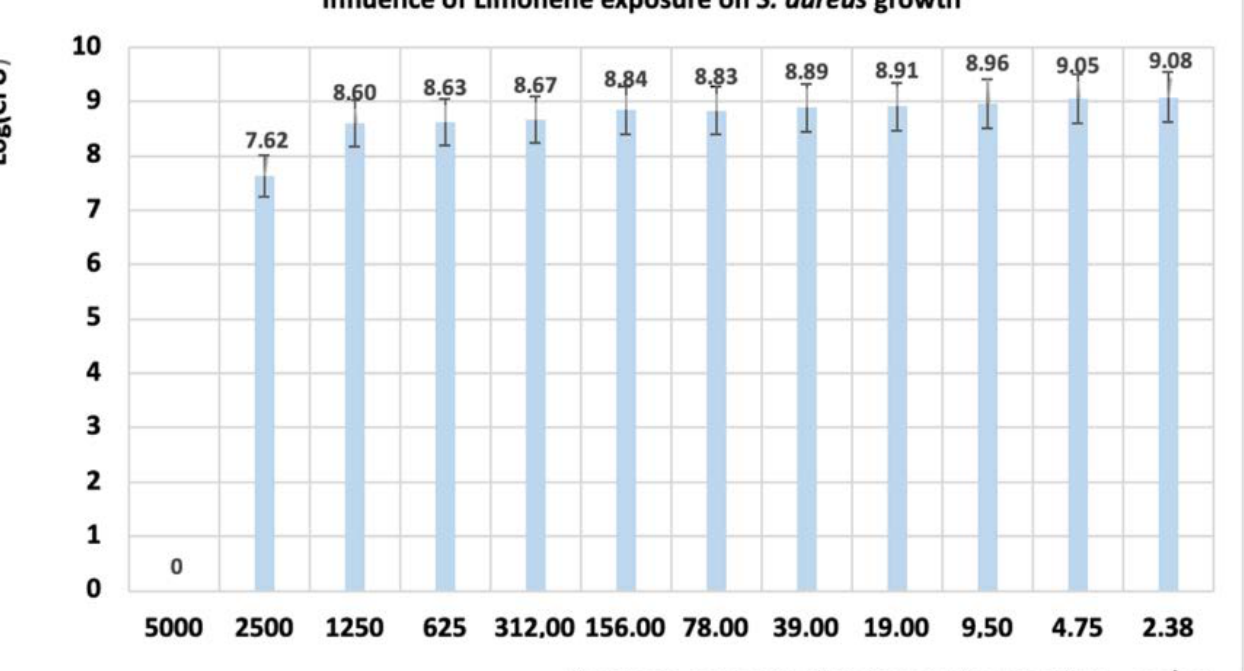
Figure 2. Influence of limonene exposure on S. aureus growth, after 24 h. At a concentration of limonene in the culture medium higher than 2500 μg/mL, S. aureus is inhibited. Other scientists obtained similar results on commercial CT formulation